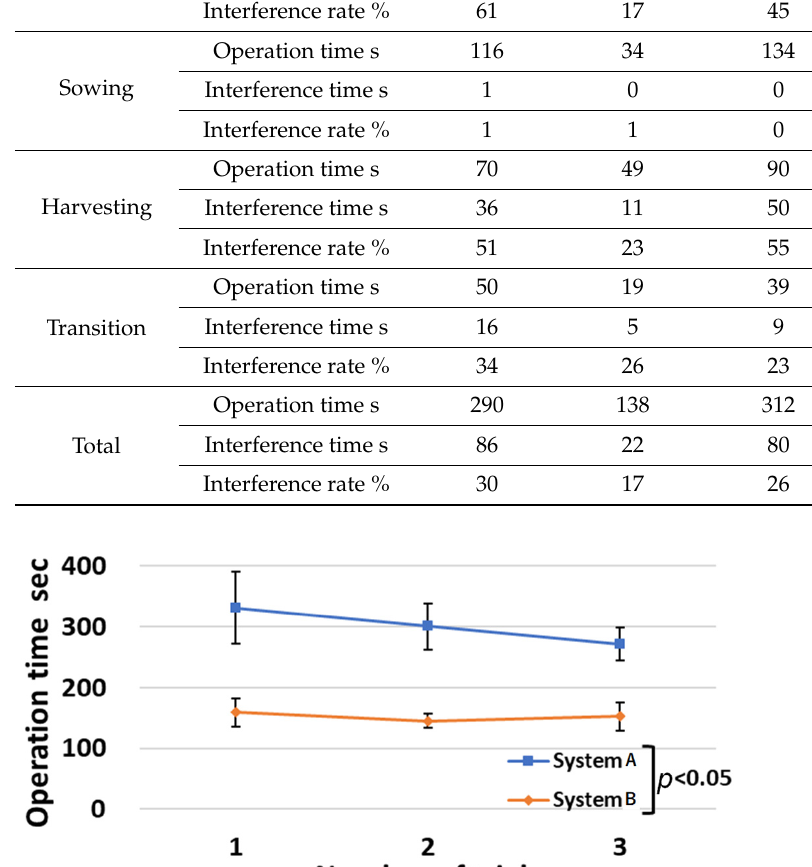
Table 5. Average operating time and interference time and interference rate with obstacles for two groups of subjects.